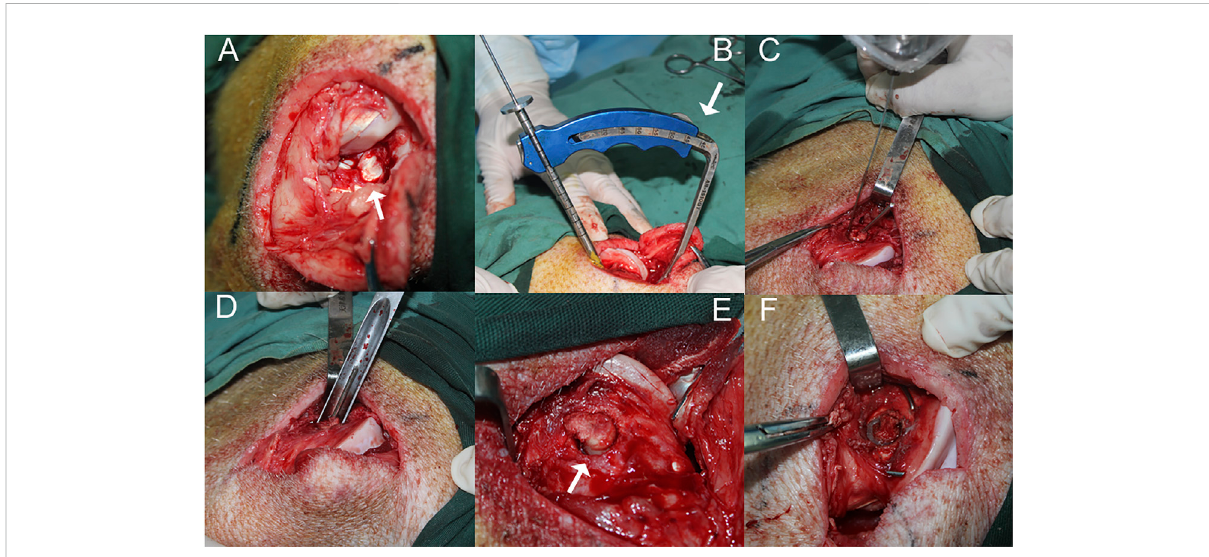
FIGURE 1 ThesurgicalprocedureperformedontherighthindlimbofaminipigintheIACL-RandIACL-R+ α 2MRSgroups. (A) Thesti fl ejointwasopenand thepatellawasdislocatedtoexposetheACL(arrow). (B) TheACLreconstructionguidewaspositionedata45 ° angle(arrow)tothelongitudinalaxisof thefemur. (C) Beforethehollowdrillwasabouttopenetratethefemoraltunnel,aKirschnerwire(diameter1 mm)wasdrilledalongouteredgeofthe tunnel to prevent the cartilage from splitting. (D) The tunnel was gently penetrated by the same diameter thin-walled ring osteotomy to completely severv tendon-bone segment (E) The tendon-bone segment was completely freed (arrow). (F) The tendon-bone segment was fi xed in situ with two crossed Kirschner